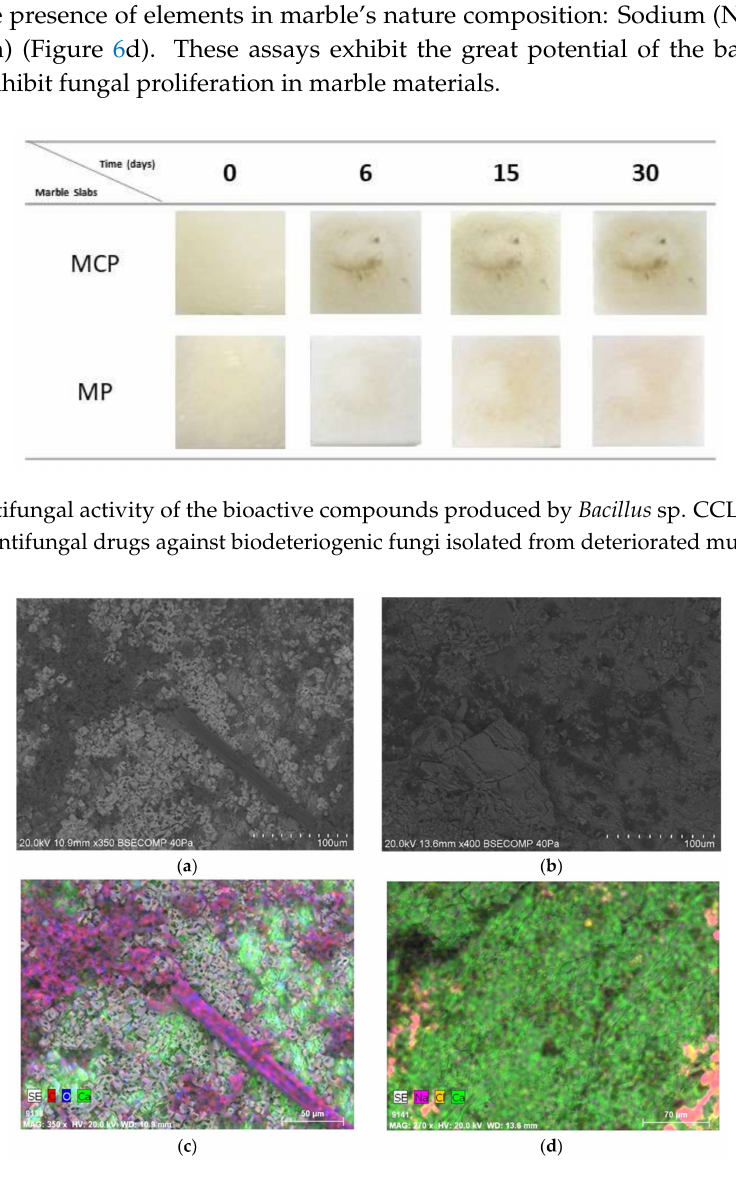
Figure 6. SEM micrographs of fragments of MCP and MP marble slabs ( a , b ) and EDX analysis on the same fragments ( c , d ). ( a , c ) MCP slabs inoculated with P. glandicola CCLBH-MP101. ( b , d ) MP slabs treated with the biocompounds produced by Bacillus sp. CCLBH